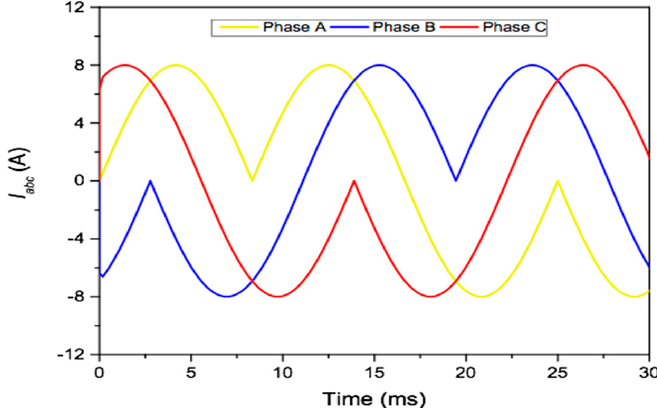
Figure 5. Three-phase armature currents ( I abc ).